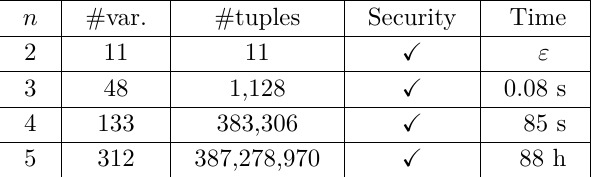
Table 4: Formal verification of the t -SNI property of the Boolean to arithmetic conversion algorithm from [Cor17c], for t = n − 1. n #var. #tuples Security